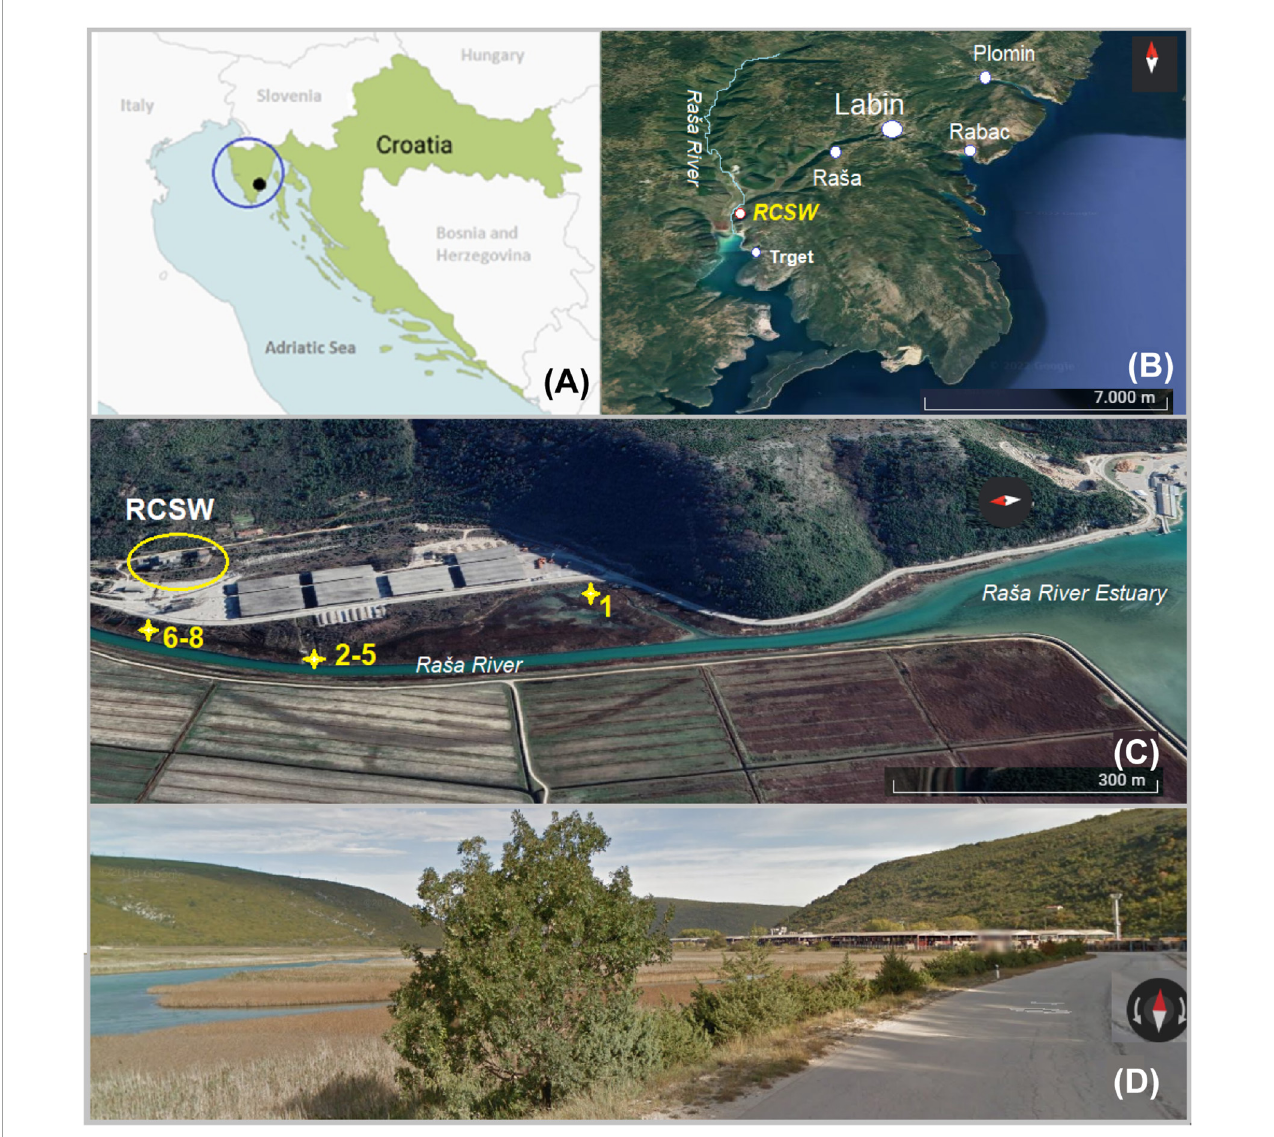
FIGURE1 Map of the study area: (A) Position of the study area (black dot) on Istrian Peninsula (blue circle) in Croatia (Europe); (B) position of sampling sites on the eastern part of Istria with Raša River and position of coal processing facility (RCSW); (C) position of sampling sites No. 1-8; (D) street view of the sampling